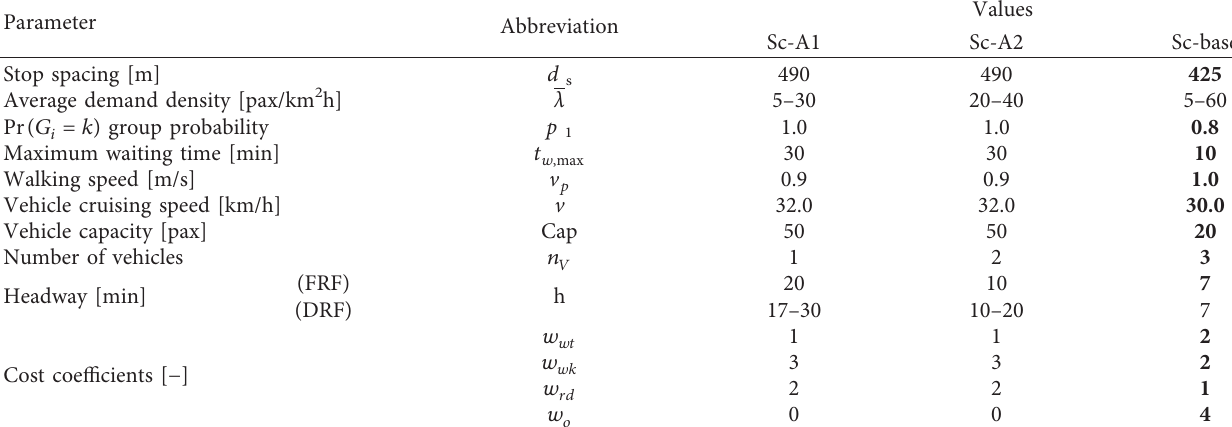
Table 3: Input parameters adopted for the first set of simulated scenarios.